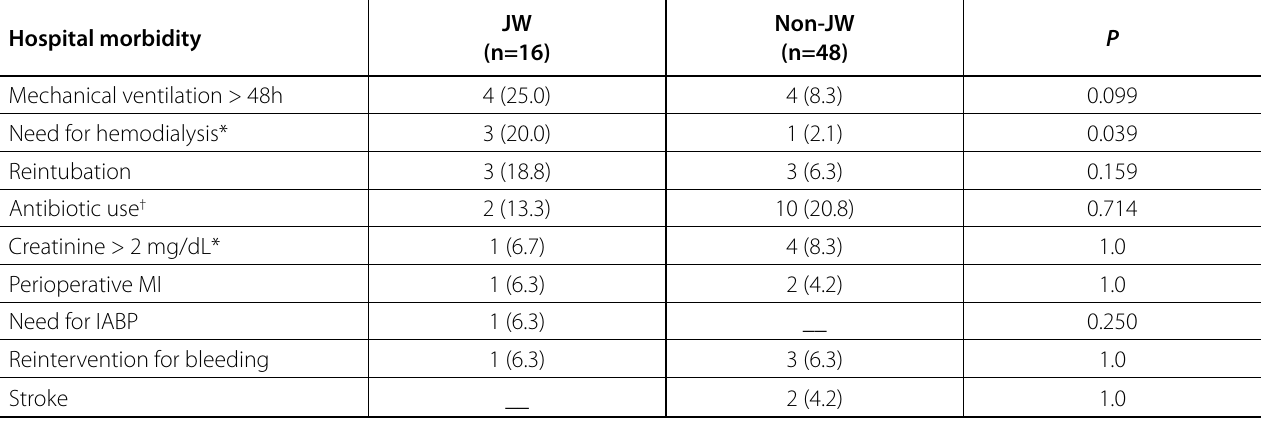
Table 4. Hospital